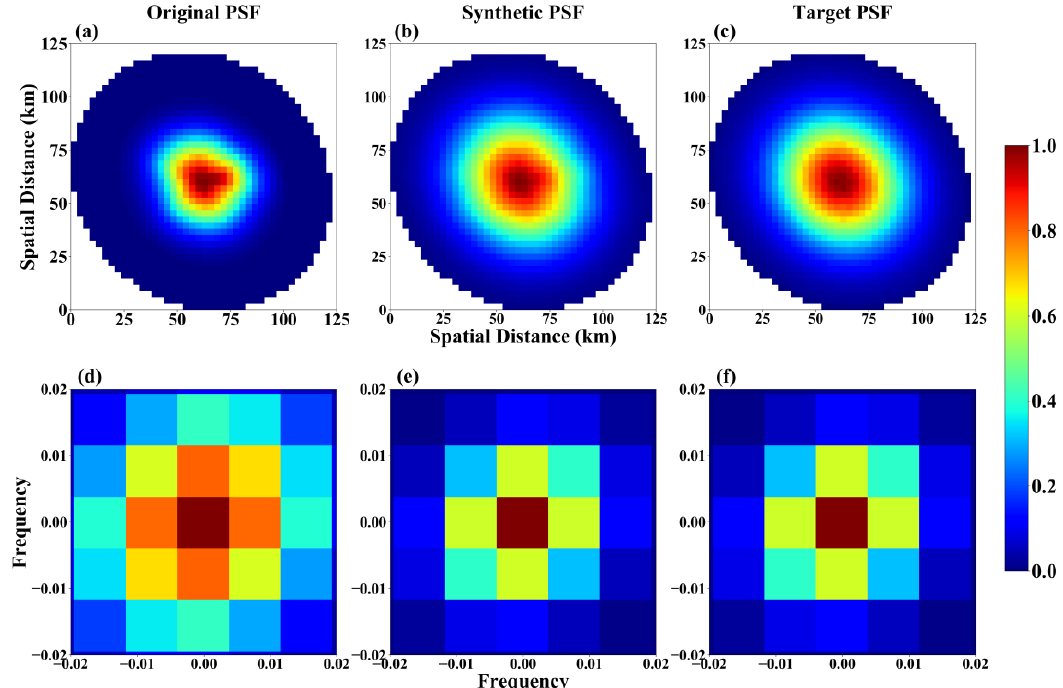
Figure 3. The BGI reconstruction from ATMS channel 3 to an AMSU-A PSF at nadir. ( a ) The original ATMS channel-3 PSF, ( b ) the reconstructed AMSU-A-like PSF, and ( c ) the target AMSU-A PSF. ( d–f ) are the Fourier transforms of the PSFs ( a – c ). All response functions have been normalized to 1.0 to facilitate comparisons.